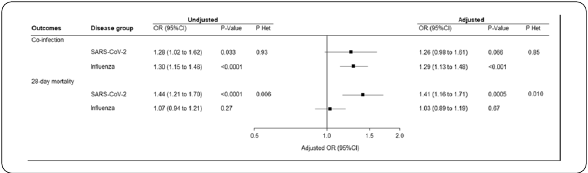
Figure 1 Unadjusted and Pre-specified Adjusted Odds Ratio of Co-infection and 28-day mortality per log increase in highest level of